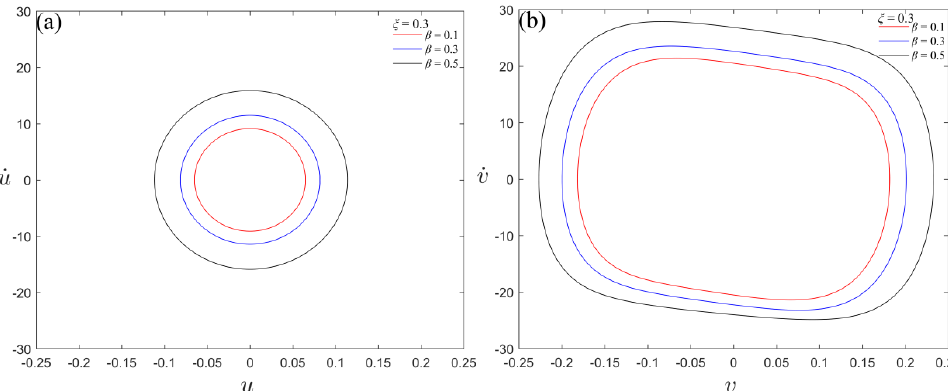
Figure 4. Comparison of phase diagrams between beam without NES and NES in the beam–NES system; ( a ) phase diagram of beam without NES at a frequency of 140.5 rad/s, ( b ) phase diagram of NES in the beam–NES system at a frequency of 136 rad/s.